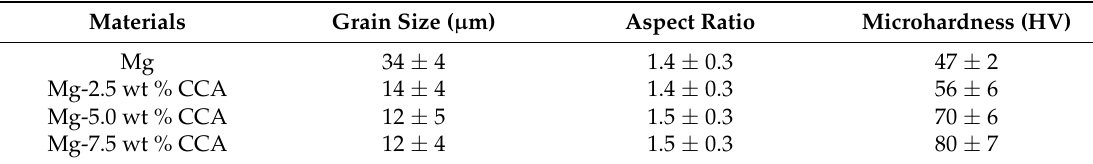
Figure 4. Grain size distribution graphs of the: ( a ) Mg and ( b ) Mg-2.5CCA; ( c ) Mg-5CCA; and ( d ) Mg- 7.5CCA composites. Table 1. Results of grain morphologyy and microhardness. Table 1. Results of grain morphologyy and